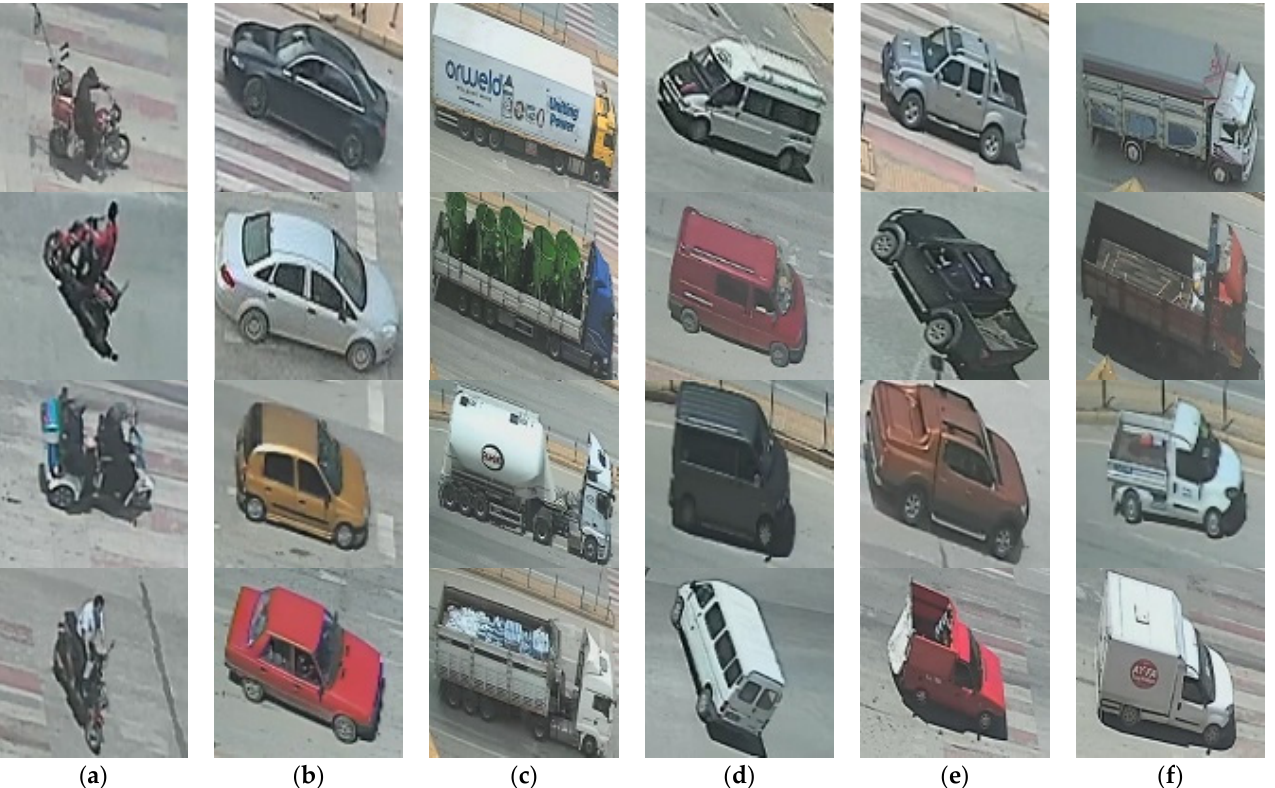
Figure 4. Samples of vehicles: ( a ) bike, ( b ) car, ( c ) juggernaut, ( d ) minibus, ( e ) pickup, and ( f ) truck.